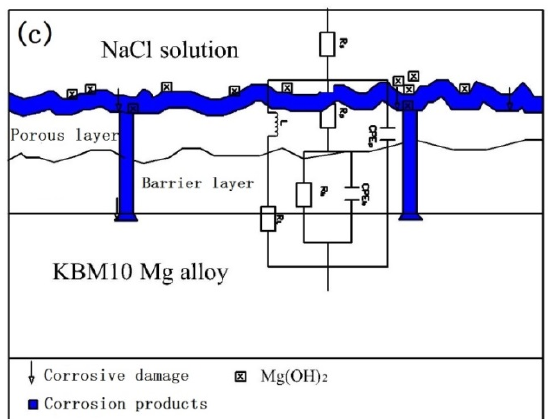
Figure 13. Degradation stage diagram of (350–6) in NaCl solution: ( a ) 24 h; ( b ) 48 h, 96 h; and ( c ) 192 h, 386 h, 768 h.